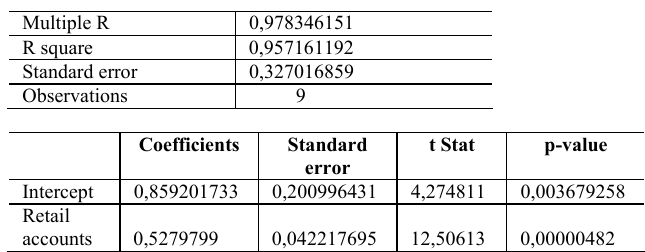
Table 4: Regression